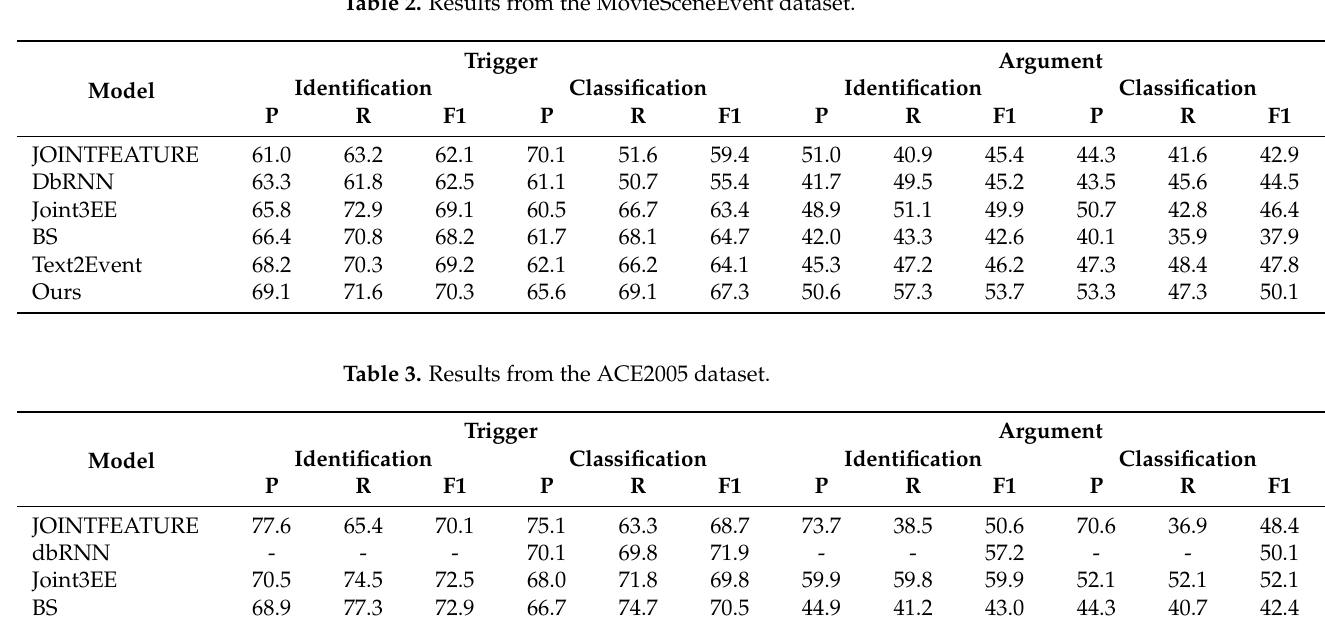
Table 2. Results from the MovieSceneEvent dataset.